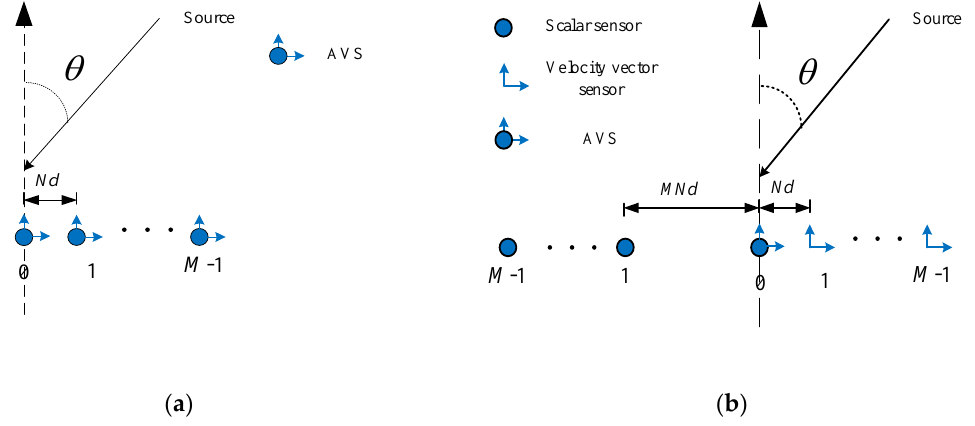
Figure 1. ( a ) Traditional AVS array; ( b ) the proposed SSN-AVS array.